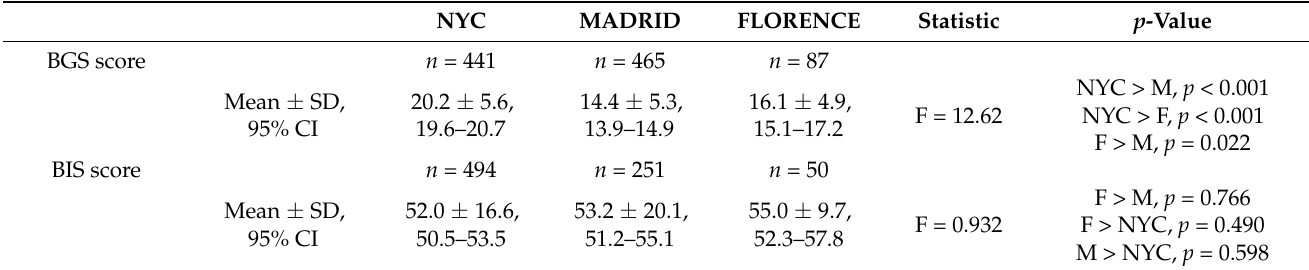
Table 2. Differences in aggression and impulsivity scores across sites.